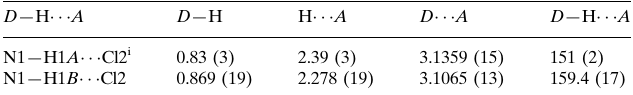
Hydrogen-bond geometry (A˚ , (cid:3)